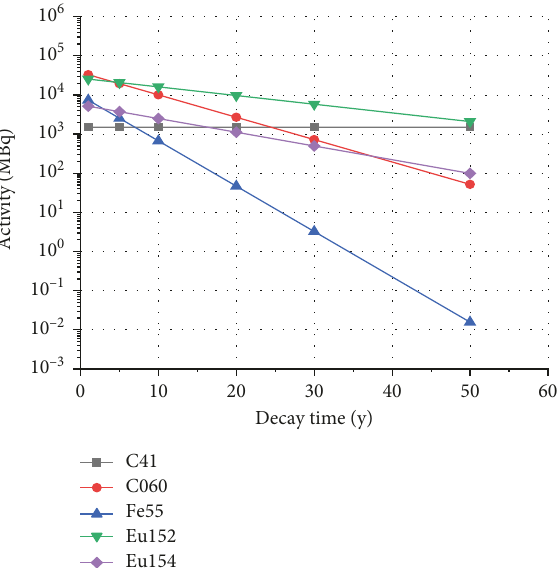
Figure 8: Activity of long-lived nuclides in the graphite with the decay time up to 50 years.